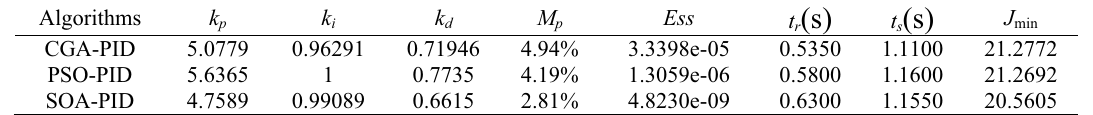
Table 2. The parameters of three PID